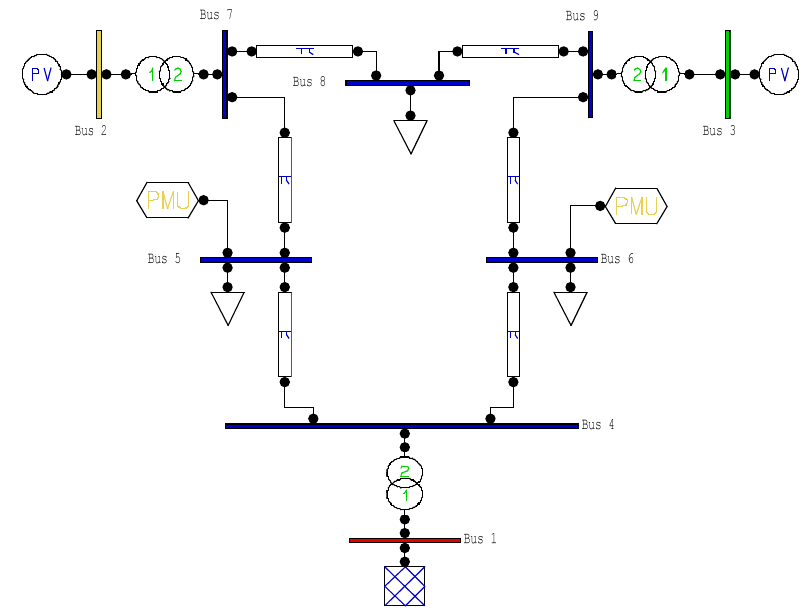
Figure 4. One ‐ line diagram of IEEE 9 ‐ bus system with phasor measurement units (PMUs). PV: PV generaotr bus (voltage ‐ controlled bus).